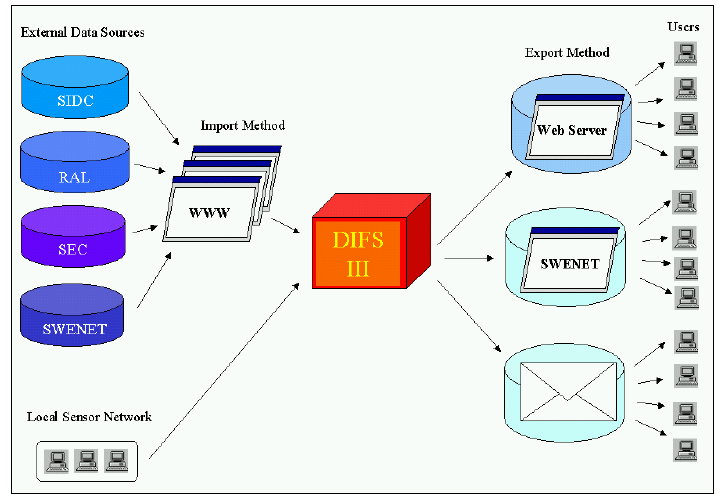
Fig. 2. Scatter plot showing ICF comparison from 14 October 2004 to 1 February